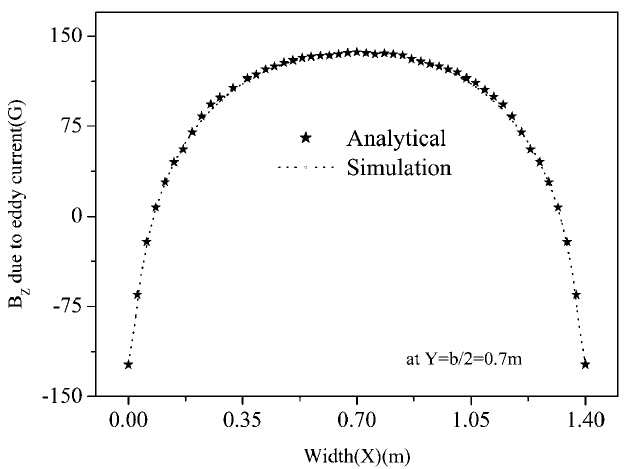
FIG. 12. Vertical component of the magnetic field, B to eddy current, at the middle of the two parallel aluminum plates of dimension ð 1 : 4 ; 1 : 4 ; 0 : 002 Þ m 3 kept at 20 mm apart. Simulation results (dotted lines) are also plotted for comparison.